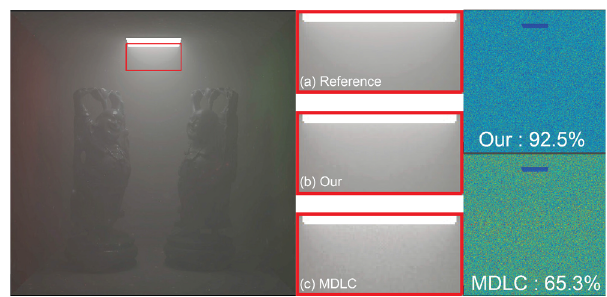
Fig. 5 Cornell box scene with participating media.